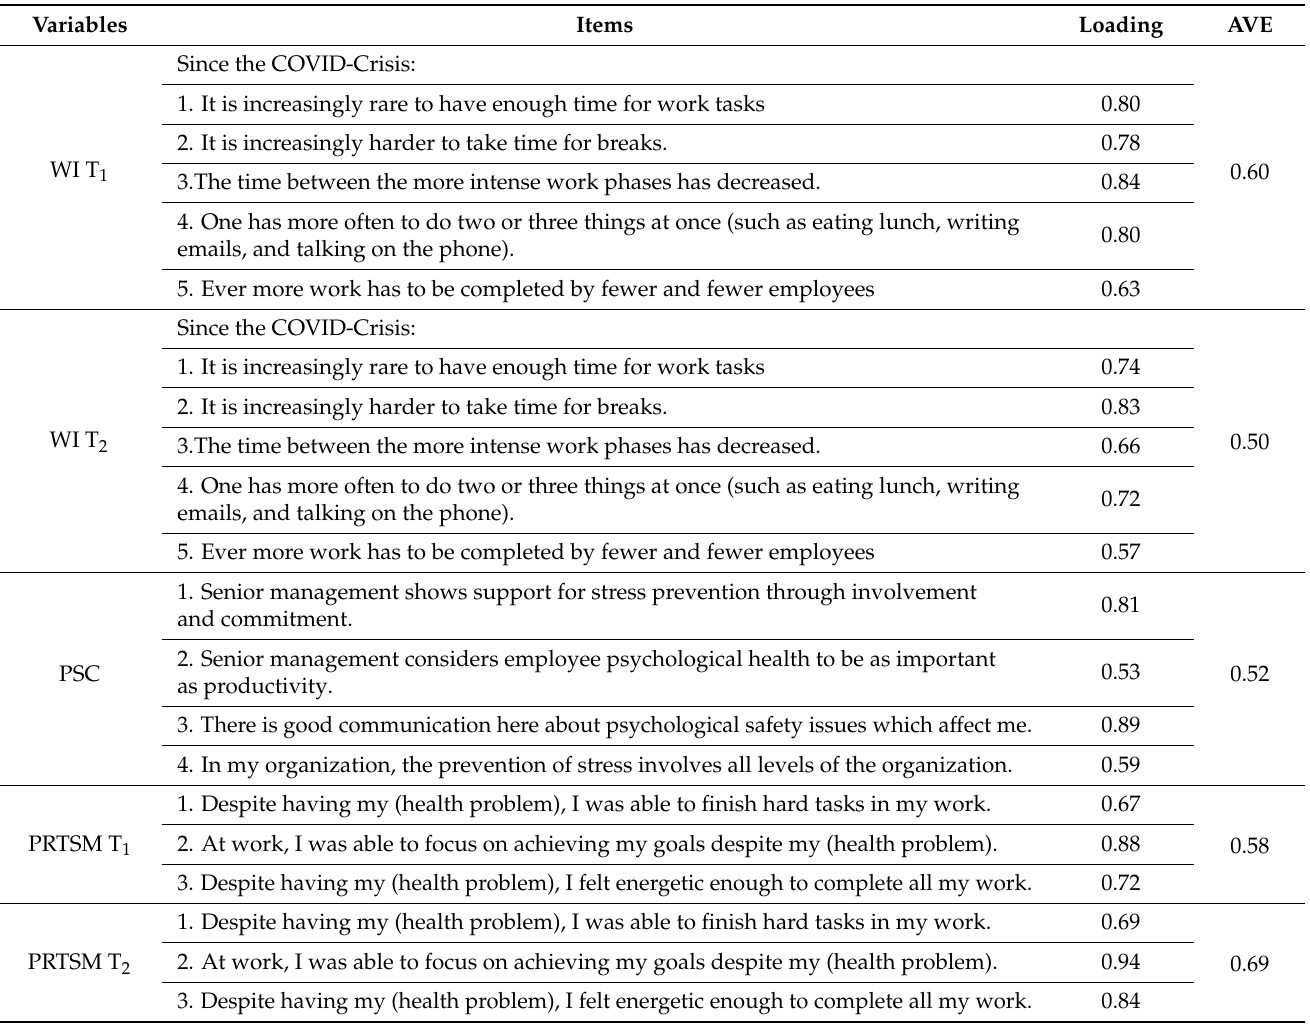
Table 2. Items loading and convergent validity